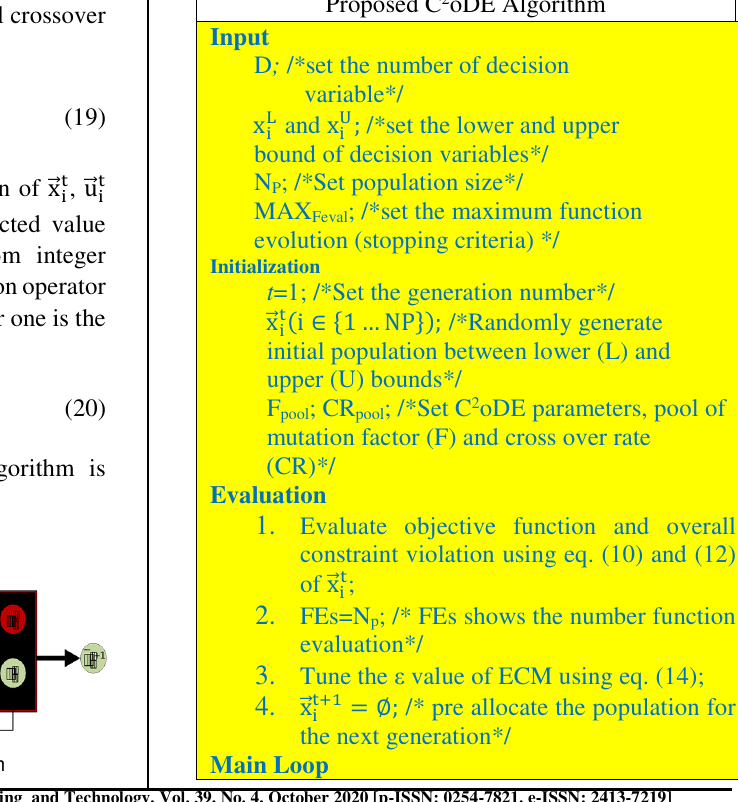
Table 1: Pseudocode of Proposed C 2 oDE Algorithm Proposed C 2 oDE